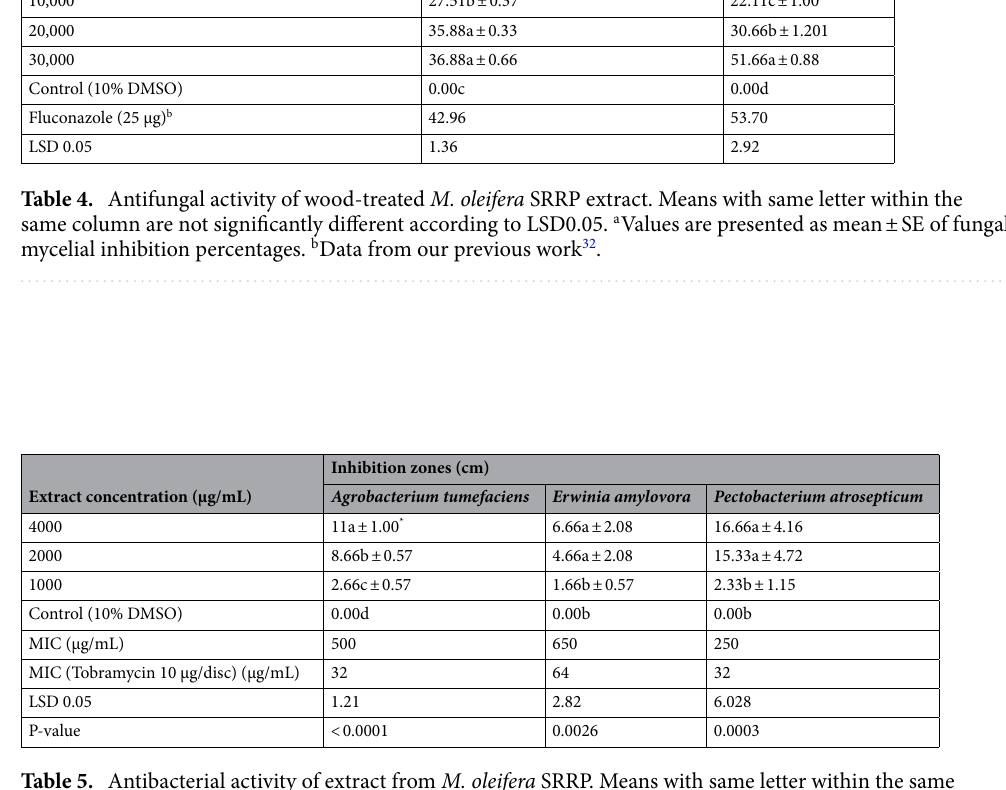
Table 5. Antibacterial activity of extract from M. oleifera SRRP. Means with same letter within the same column are not significantly different according to LSD0.05. MIC Minimum inhibitory concentration (µg/mL). * Values are presented as mean ± SE of the inhibition